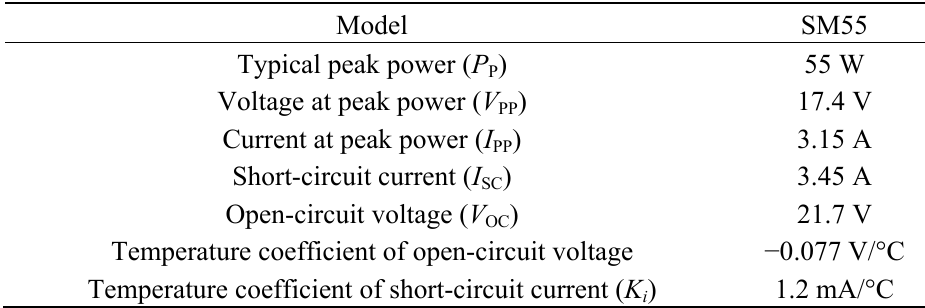
Table 1. Electrical characteristics of the used PV module (SIEMENS SM55).